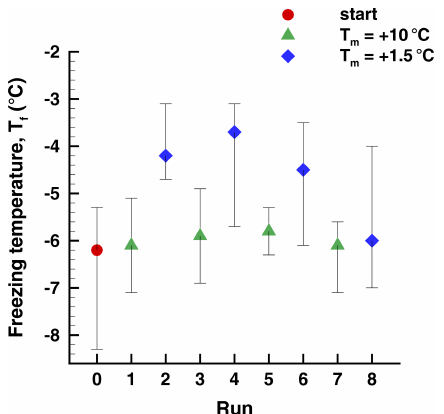
Figure 15. Freezing temperatures in a sequence of runs (Exp. H) with alternating high and low warm limits, T w . The 50th percentile is indicated by the symbols, and the vertical lines show the 5th- and 95th-percentile values.